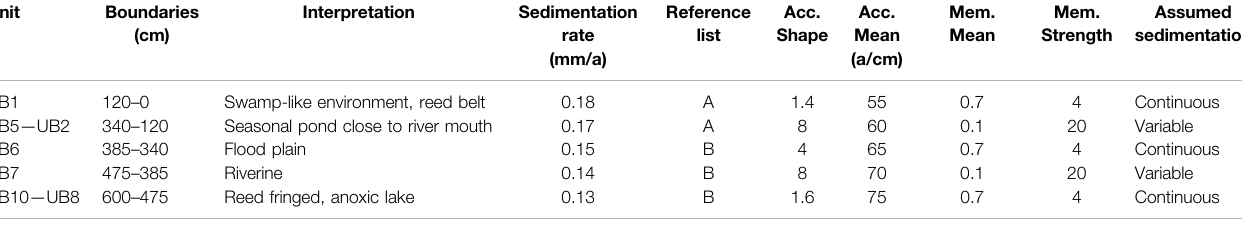
TABLE 3 | Input parameters for the Bacon age model and the environmental interpretation based on this study and lithological descriptions by Karkanas et al. (2018).